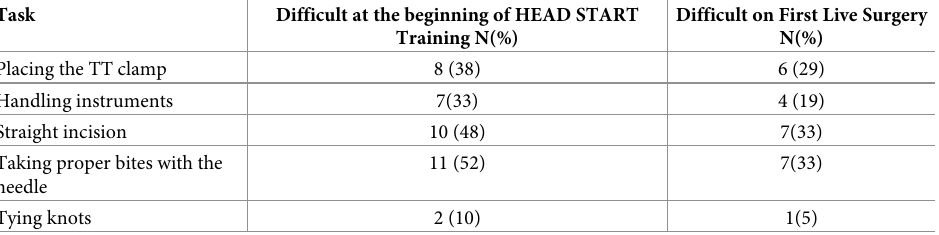
Table 3. Trainee Self-Assessment of Difficulty in Performing Tasks at the Beginning of HEAD START training and Live-training Surgeries.